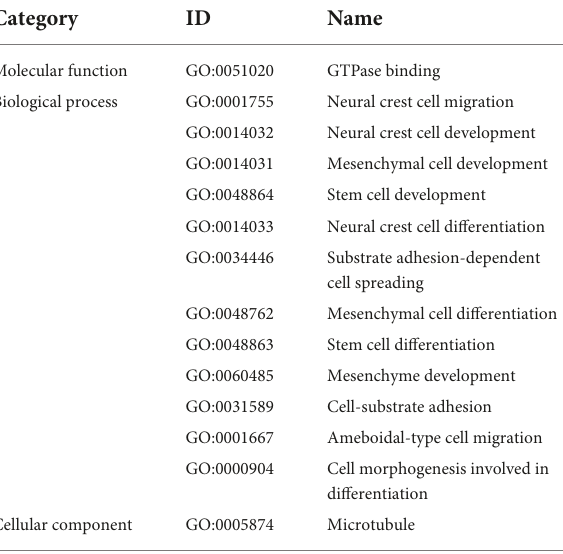
TABLE 2 Functional relevance of the RADIL gene based on gene ontology (GO)